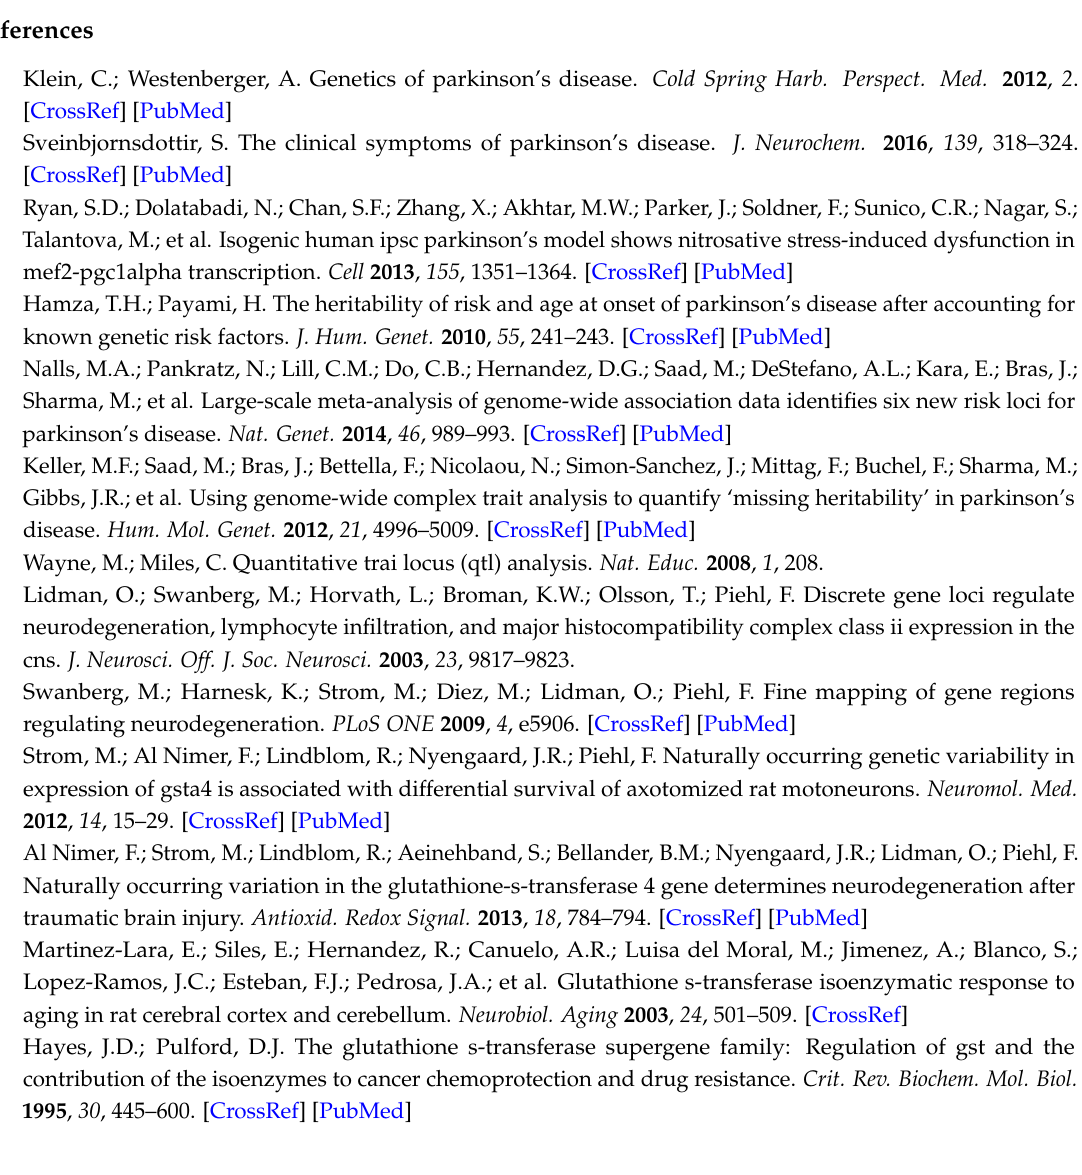
Figure S1: Gsta4 gene expression in the striatum and midbrain 7 days after striatal 6-OHDA lesion, Figure S2: Expression of GSTA4 in striatal astrocytes 8 weeks after 6-OHDA